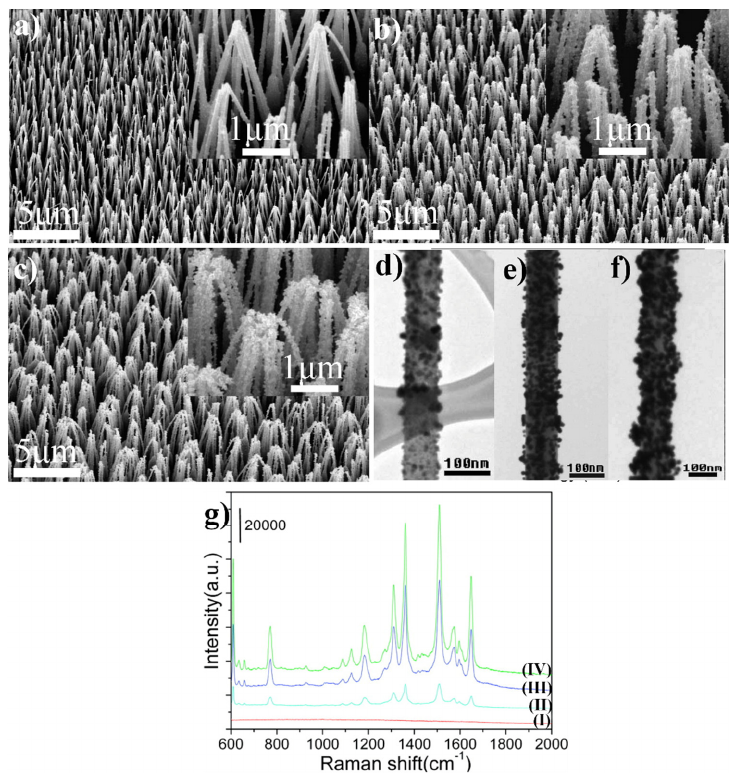
Figure 9. ( a – c ) SEM images of ZnO/Au nanoneedle arrays prepared at different HAuCl 4 concentrations: ( a ) 0.1, ( b ) 0.3 and ( c ) 0.5 mM. Inset shows corresponding high magnification SEM images. ( d – f ) TEM images of ZnO/Au nanoneedles prepared at different HAuCl 4 concentrations: ( d ) 0.1, ( e ) 0.3 and ( f ) 0.5 mM. ( g ) SERS spectra of molecules of rhodamine 6G adsorbed on: (I) ZnO (II), (III) and (IV) ZnO/Au produced using HAuCl 4 at various concentrations: 0.1, 0.3 and 0.5 mM, respectively. Reprinted with permission from [42]. Copyright 2009 American Chemical